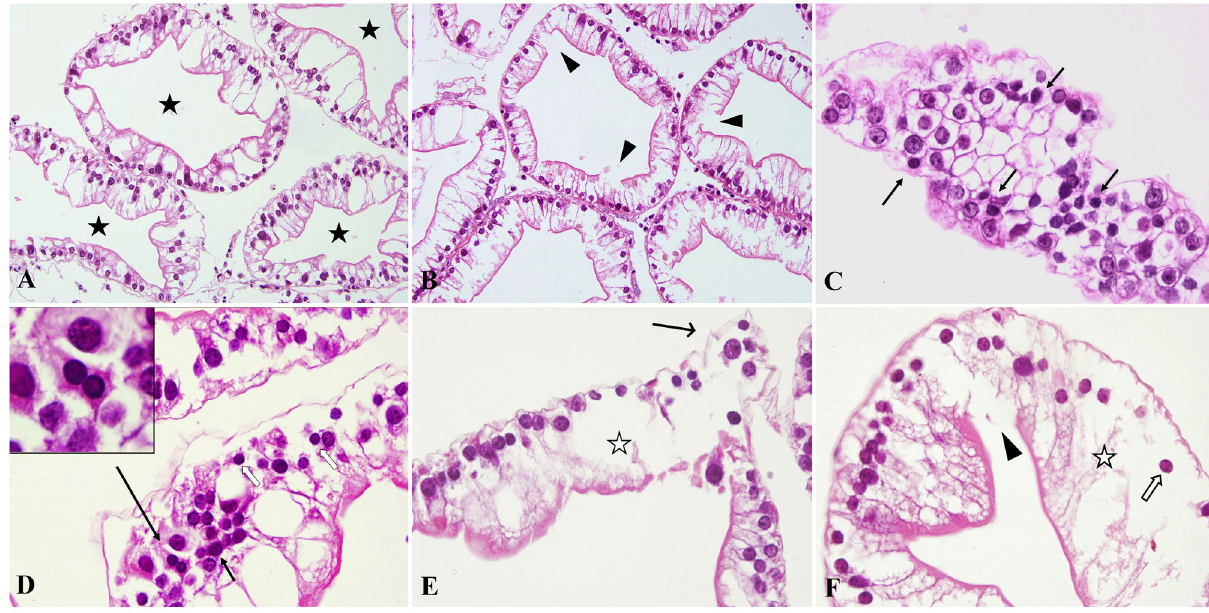
Figure 1. Morphological injury induced by Cd in S. henanense hepatopancreas with paraffin sections and HE staining ( n = 6). ( A ) Normal tissue in the control group, ×200. The hepatopancreas glands were circular or elliptical, and the inner surface was irregular but continuous. ( B ) A few cells were damaged and the continuation of the inner surface was broken in the 3.56-mg/L Cd group, ×200. ( C ) Transverse section of the hepatopancreatic gland in the 3.56-mg/L Cd group, ×600. Cells arrange like the honeycomb. Classical apoptosis bodies (arrow) with chromatin aggregation and more acidophilia of cytoplasm were smaller than the surrounding ones. ( D ) Apoptosis was easily identifiable in the 7.12-mg/L Cd group, ×600. Classical apoptotic bodies are shown in the upper left corner. ( E ) Severely cellular swelling and damage were present in the 28.49-mg/L Cd group, ×400. ( F ) Broken epithelia, grave cell swelling and necroptosis were present in the 56.98-mg/L Cd group, ×600 ( ★ : hepatopancreas glandular